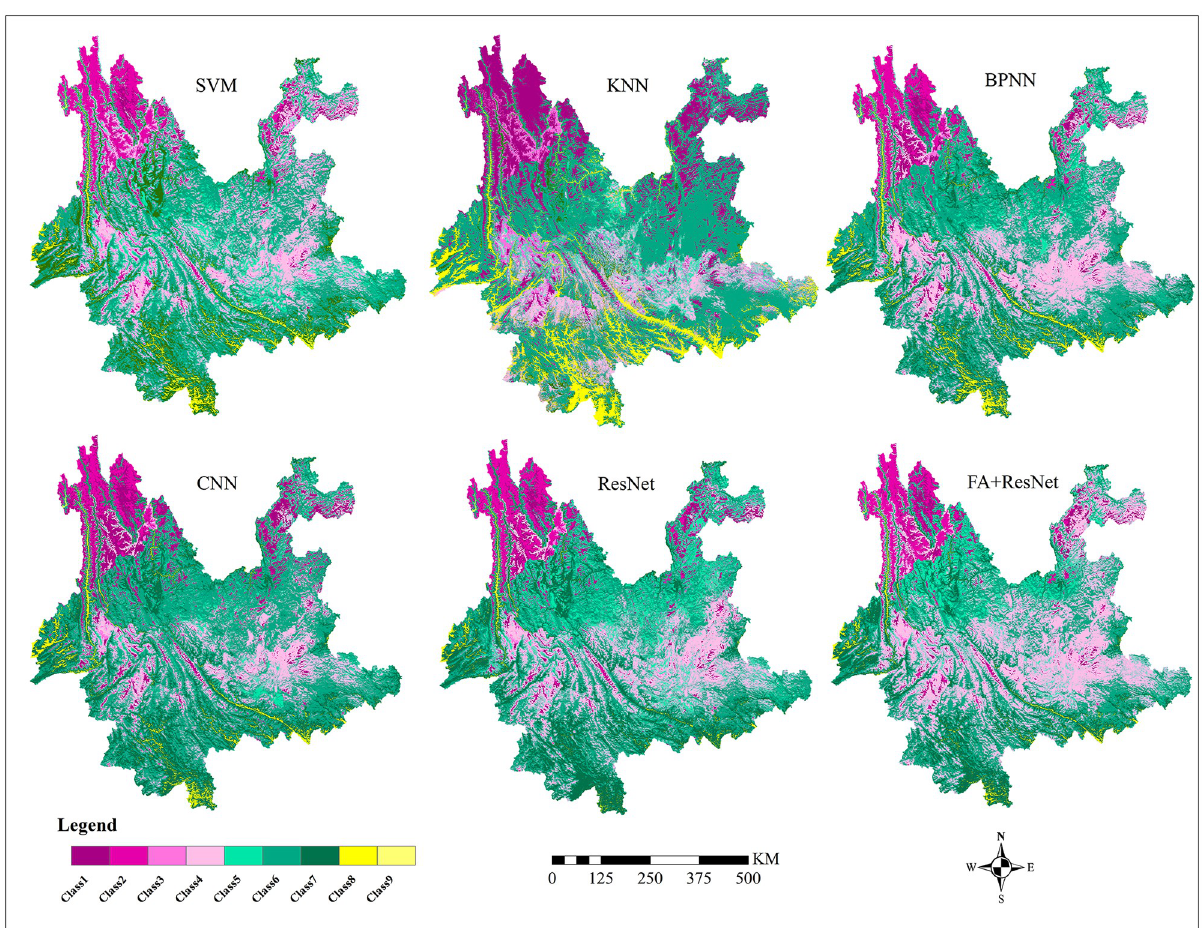
Fig 16. The classified predicted suitable areas of premium teas using remote sensing variables in six models: (a) SVM; (b) kNN; (c) BPNN; (d) CNN); (e) ResNet; (f) FA+ ResNet. The suitability of premium teas increase gradually from Class 1 to Class 9. Class 9 is the most suitable areas for premium teas growth, while Class 1 is the least suitable area for premium teas growth. Shape file source: republished from http://www.gscloud.cn under a CC BY license, with permission from Geospatial Data Cloud, original copyright [2022]; Own Map output: using ArcGIS 10.8 Software